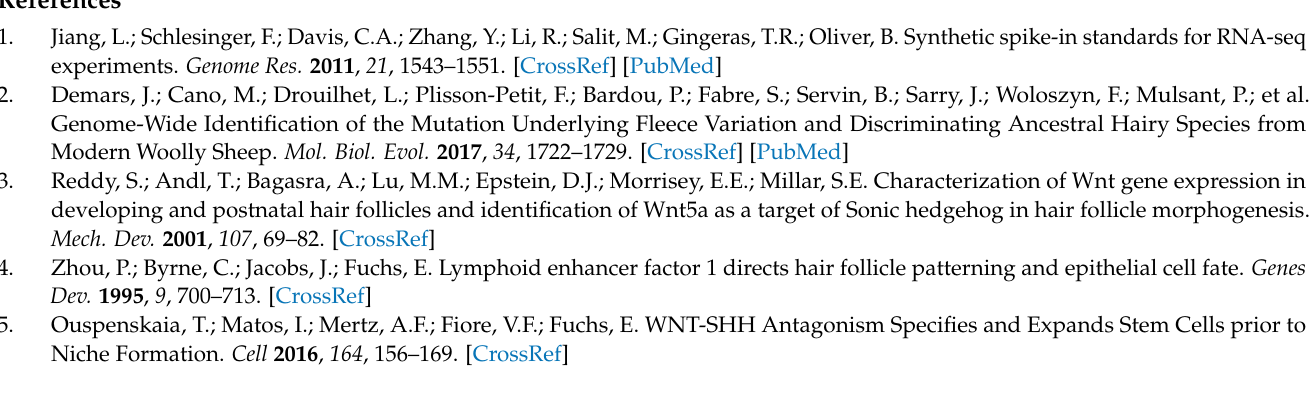
mosome distribution; Figure S2: Pearson correlation between samples; Table S1: Primers information of miRNAs and mRNAs; Table S2: Overview of the quality control of miRNA reads generated from hair follicle tissues; Table S3: DE miRNAs from SM vs. ST in hair follicle; Table S4: Overview of the quality control of mRNA reads generated from hair follicle tissues; Table S5: DE mRNAs from SM vs. ST in hair follicle; Table S6: GO enrichment analysis of target genes; Table S7: KEGG enrichment analysis of target genes; Table S8: Target genes prediction analysis of DE